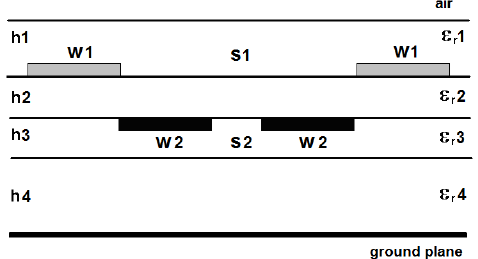
Figure 2. Cross ‐ sectional view of a multilayer dielectric structure used for the design of differential bi-level microstrip 3-dB directional bi ‐ level microstrip 3 ‐ dB directional coupler.